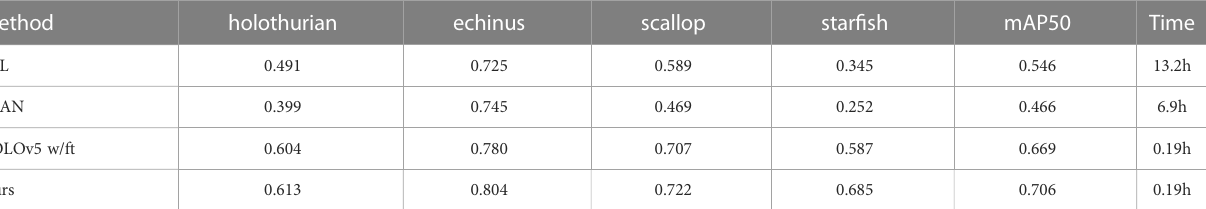
TABLE 1 Our comparison results with other methods on the S-UODAC dataset.